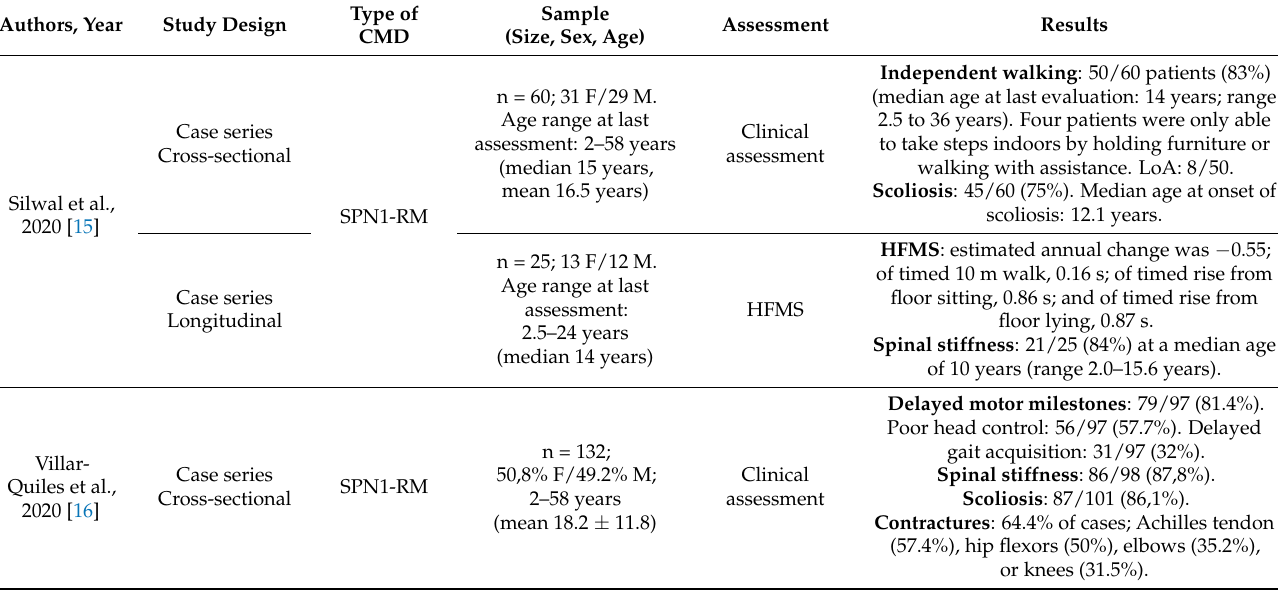
Table 5. Motor outcome measures in patients with SEPN1-RM (SPN1-RM: SEPN1-related myopathies HFMS: Hammersmith Motor